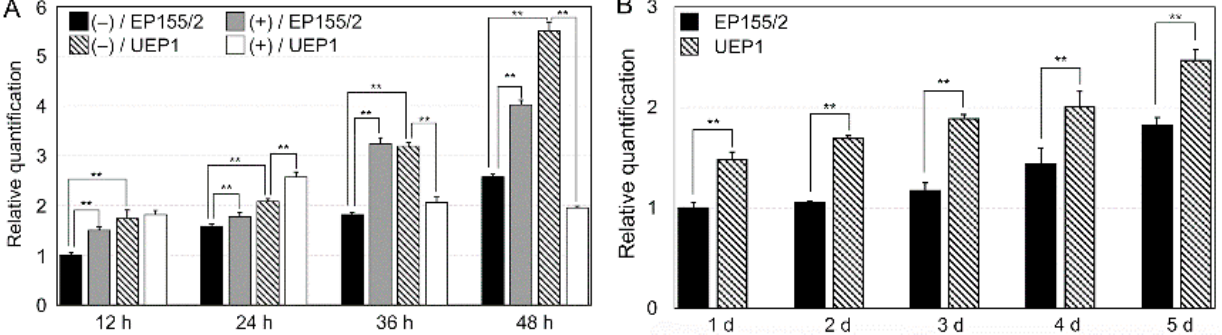
Figure 1. Expression analysis of CpRan1 . ( A ) qRT-PCR analysis of the expression levels of CpRan1 in response to CHV1 infection and TA supplementation. Changes in expression of CpRan1 between the wild-type (EP155/2; indicated as solid bars) and CHV1-infected hypovirulent (UEP1; indicated as slashed bars) strains relative to levels of glyceraldehyde-3- phosphate dehydrogenase ( gpd ) are indicated; (+) and (–) indicate with and without TA supplementation, respectively. ( B ) qRT-PCR analysis of the expression levels of CpRan1 during cultivation in standard liquid EP complete medium. Numbers at the bottom indicate hours after the transfer ( A ) and days in liquid culture ( B ). ** indicates a significant change at p < 0.01. Error bars indicate standard deviation based on three independent